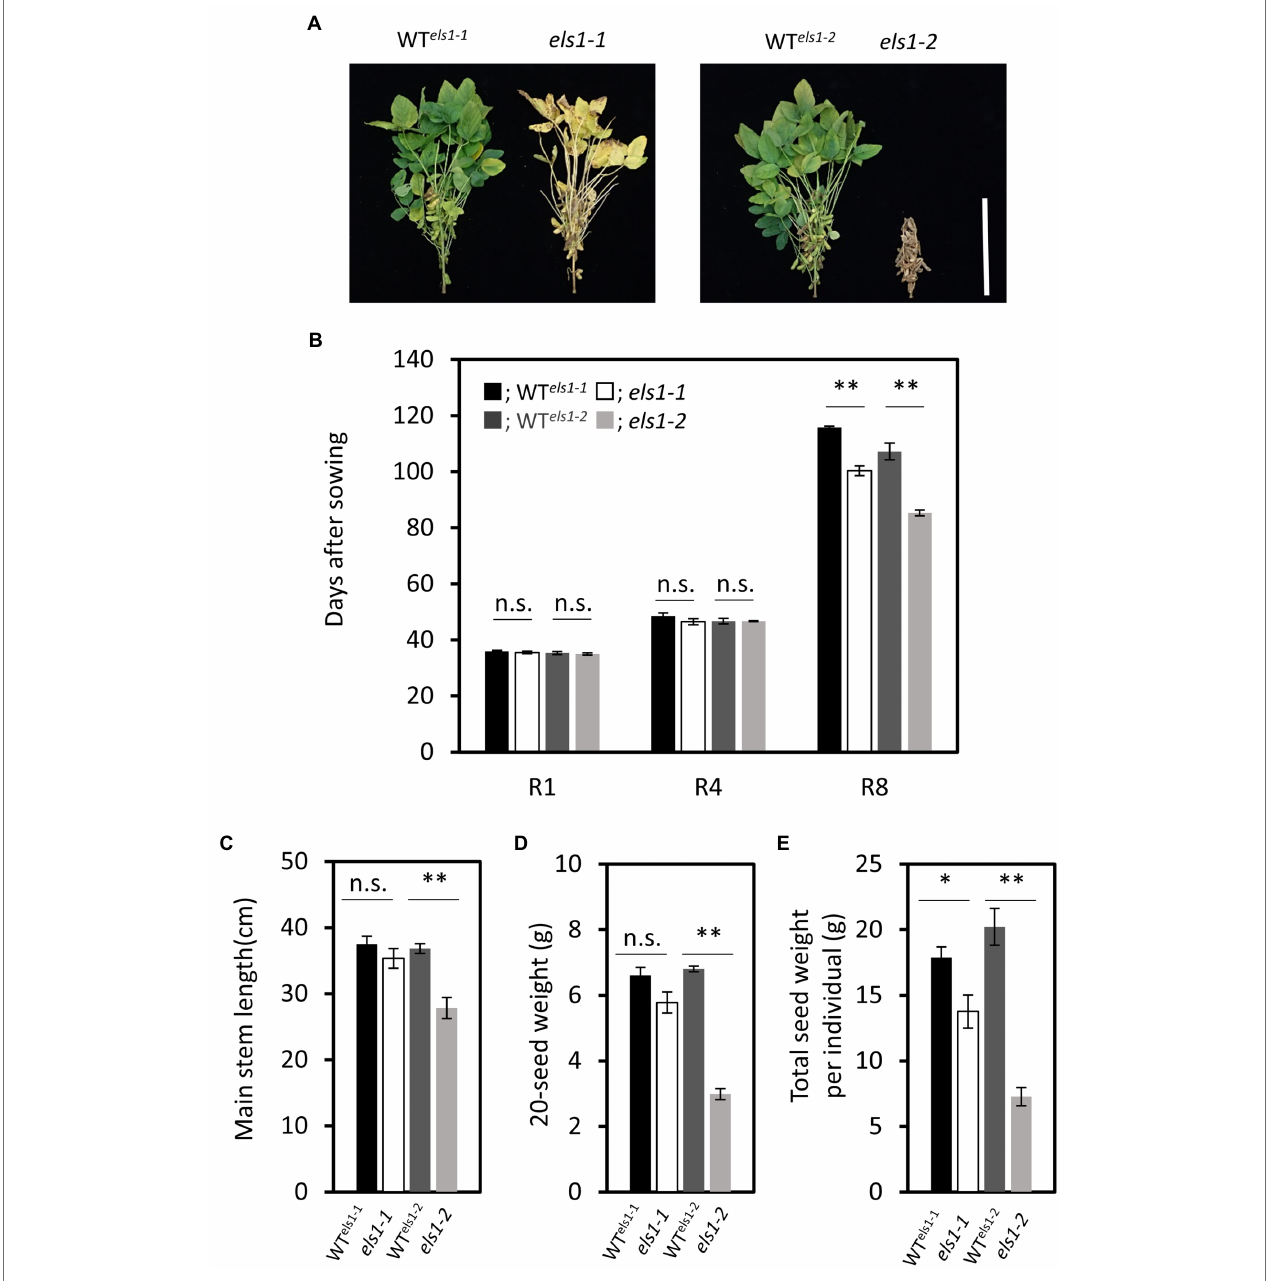
FIGURE 5 | The differences of agronomic traits between els1 and their WT . (A) Phenotype of WT els1-1 , els1-1 , WT els1-2 and els1-2 at about 80 days after sowing. The scale bar indicates 30 cm. (B) Days to each growth stage in els1 (n = 6 biological replicates). Black bars indicate WT of els1-1 , white bars indicate els1-1 . Dark gray bars indicate WT of els1-2 , light gray bars indicate els1-2 . Error bars indicate the standard error (SE). * p < 0.05, ** p < 0.01, n.s., not significant (Student’s t-test). (C) Main stem length in els1 (n = 6 biological replicates). (D) 20-seed weight of els1 (n = 6 biological replicates). (E) The total seed weight per plant in els1 (n = 6 biological